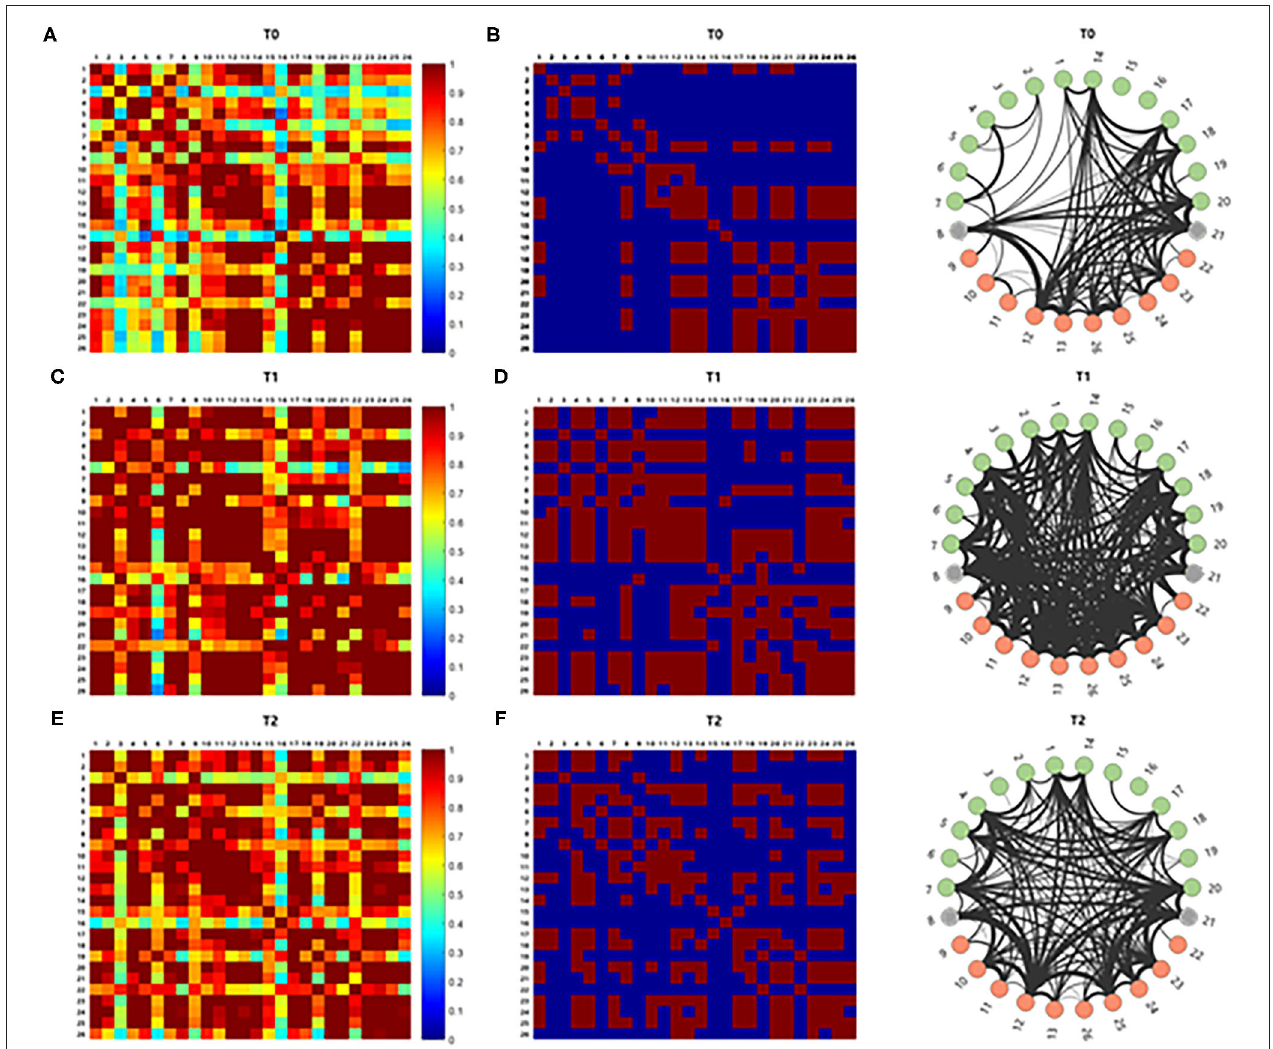
FIGURE 5 | The brain connectivity between paired channels by using correlation analysis was performed and indicated by a different color according to the intensity of the correlation (A,C,E) . Stronger cortical interactions with threshold z > 1.0 were represented by line according to thickness (B,D,F) . Those with z > 1.0 comprise 15.866% of the total interactions. The correlation analysis for comparison of the cortical interaction in the cortex showed increased strength of connectivity in the left hemisphere at T1 and T2 compared to